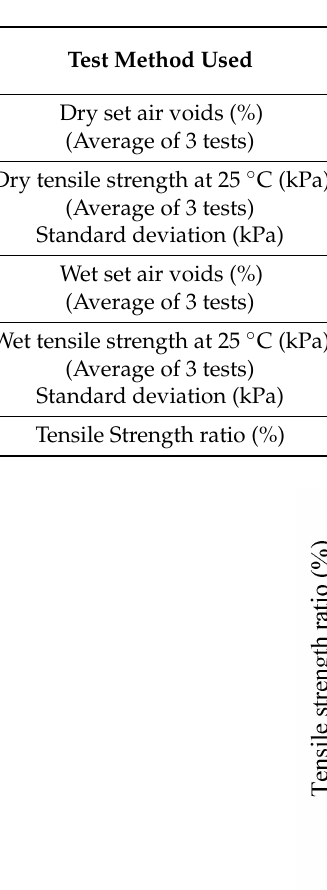
Figure 6. The results of indirect tensile strength of different asphalt mixtures. Table 7. TSR average results for HMA and WMA.